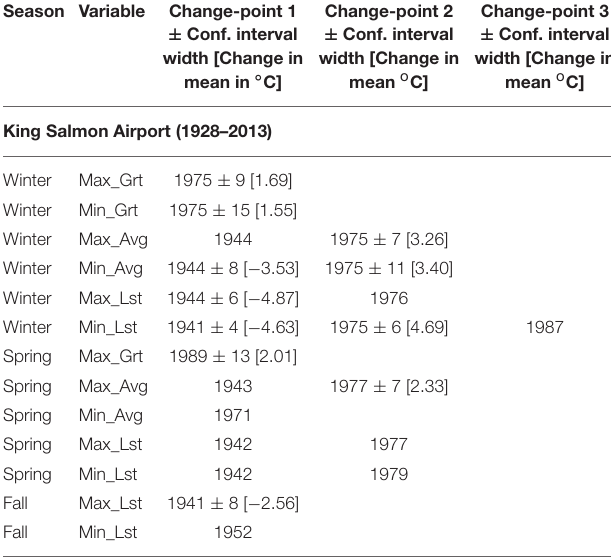
TABLE 3C | Change-points in mean for station KSA representing southwestern region of Alaska with: PELT change-point estimate ± width of approximate 95% confidence interval (when change detection test p -value < 0.05) and [amount of change in mean in ◦ C], or only PELT change-point estimate (when change detection test p -value > 0.05).